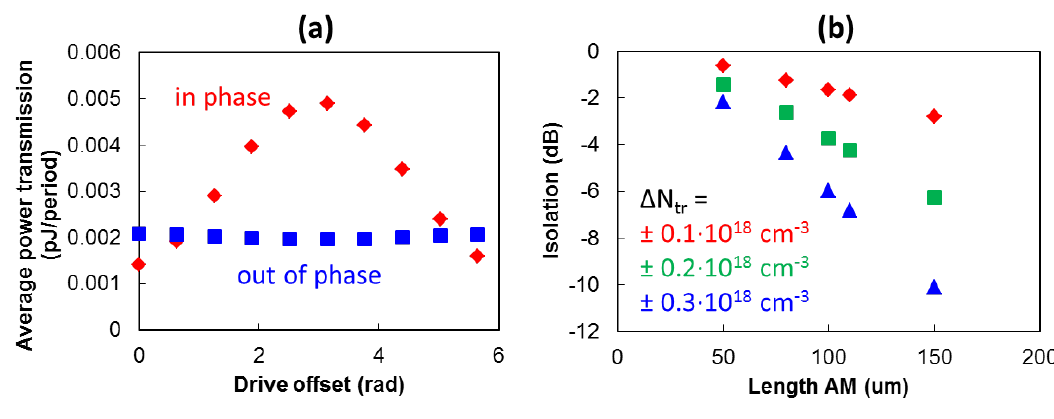
Figure 2. ( a ) Power transmission of a 1-mW peak power 20-GHz MWP signal through an isolator with a total length of 1.2 mm and with two absorption modulator (AM) sections of 100 µm. The bias amplitude corresponds to ±0.2 × 10 18 cm −3 . Referring to Figure 1, the forward transmission (red) and reverse, backward transmission (blue) are shown, as a function of the phase difference between the MWP signal and the AM driving voltage. ( b ) Maximum difference between forward and backward propagating signals for various AM lengths and driving voltages (indicated with N tr